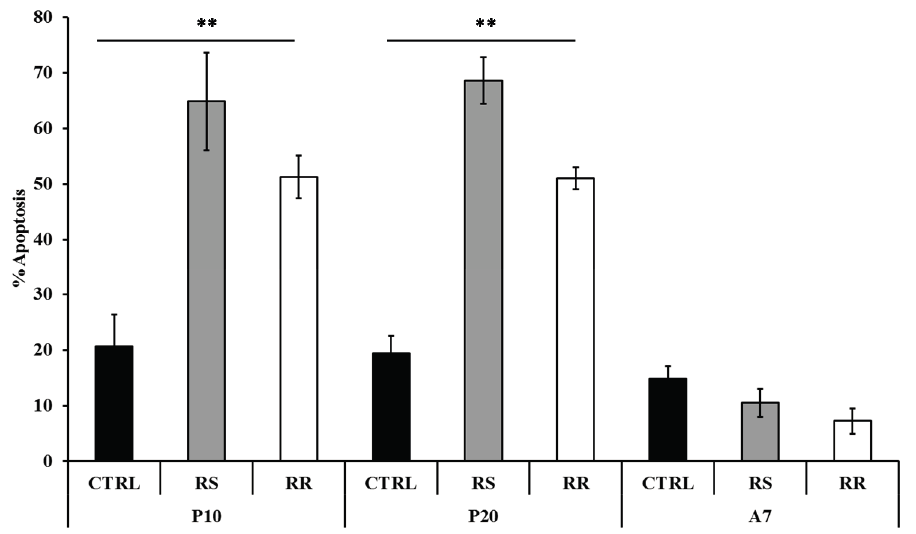
Figure 3. Modulation of apoptosis by RS and RR extracts in human omental pre-adipocytes. Cells were treated with 30 µg/mL RR and RS extracts. P10, differentiating pre-adipoctes treated for 10 d; P20, differentiating pre-adipocytes treated for 20 d; A7, mature adipocytes treated for 7 d. Data are presented as mean ± standard deviation (SD). Asterisks ** indicate the significant difference between treatments for p < 0.001 as percentage vs positive CTRL.